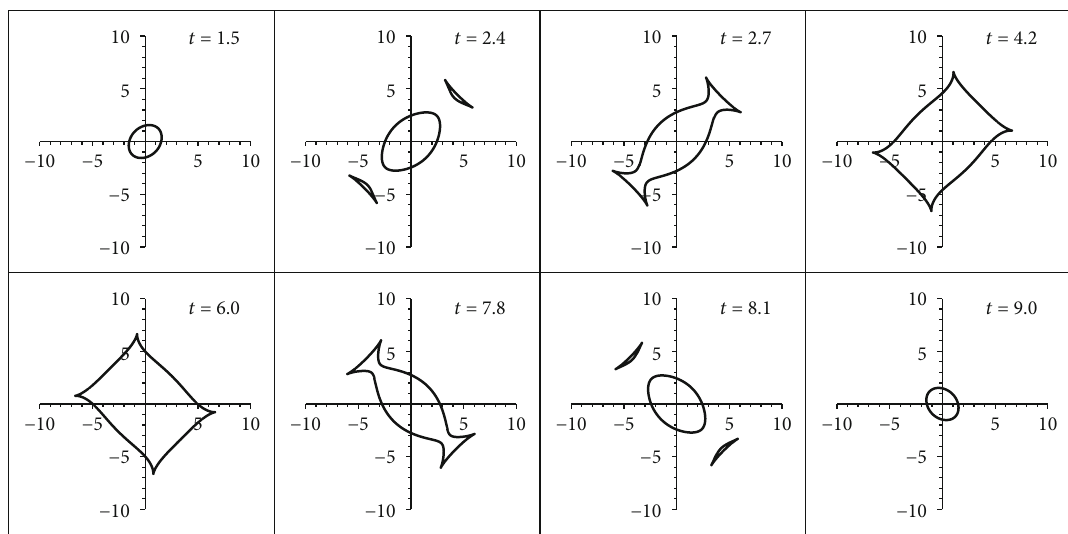
Figure 5: Wave fronts of null geodesics emitted by an observer at the origin at eight successive times. These wave fronts show bifurcations due to the non-causal nature of the time coordinate of the time coordinate shown in Figure 1. Each entire wave front of constant time, including the disconnected sections, are inside the causal boundary circle of radius 2/ α